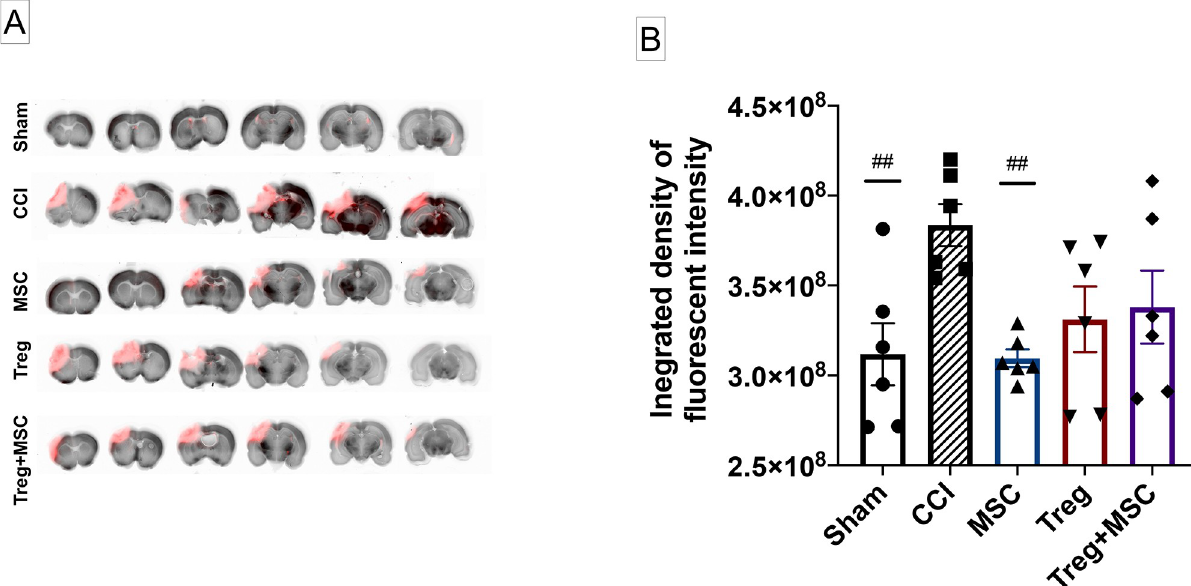
Fig 2. Assessment of blood brain barrier (BBB) permeability at 96 hours after CCI. (A) : Representative slices of the brain from forebrain to hindbrain, imaged using a LiCor Odyssey infrared scanner. Of note, the visual differences apparent between the groups do not directly correspond to quantitative changes in fluorescent intensity. (B) : Quantitative assessment of BBB permeability, measured using the integrated density of fluorescence between intensities of 257–2827 which excludes background fluorescence and the focal cortical lesion, demonstrates that the BBB remains disrupted after CCI at 96 hours compared to sham. MSC monotherapy significantly reduced BBB permeability, while Treg monotherapy (p = 0.059) and Treg +MSC (p = 0.11) trended towards improvement. There were no significant differences between treatment groups. N = 6. Values of p � 0.05 were considered significant. Statistical significance between sham/treatment and CCI is indicated with (#) for p � 0.05, (##) for p � 0.01, (###) for p � 0.001. Statistical significance between treatment groups is indicated with ( � ) for p � 0.05, ( �� ) for p � 0.01, ( ��� ) for p � 0.001. CCI, controlled cortical